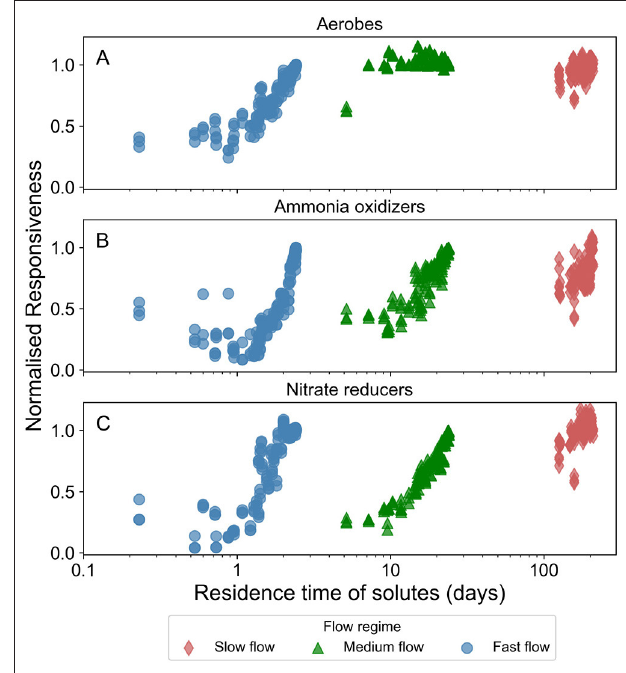
FIGURE 6 | Normalized responsiveness of concentration of active fraction of biomass in the domain in response to temporal dynamics in the forcing (changing groundwater head at the inlet of the domain). The color varies with the prevalent flow regime (red for slow flow, green for medium flow, and blue for fast flow regimes). Normalized responsiveness close to 1 indicates that the temporal dynamics induced in a spatially heterogeneous domain is similar to those induced in the corresponding homogeneous domain. (A) Displays the data for active aerobic degraders (aerobes), (B) for active ammonia oxidizers, and (C) for active nitrate